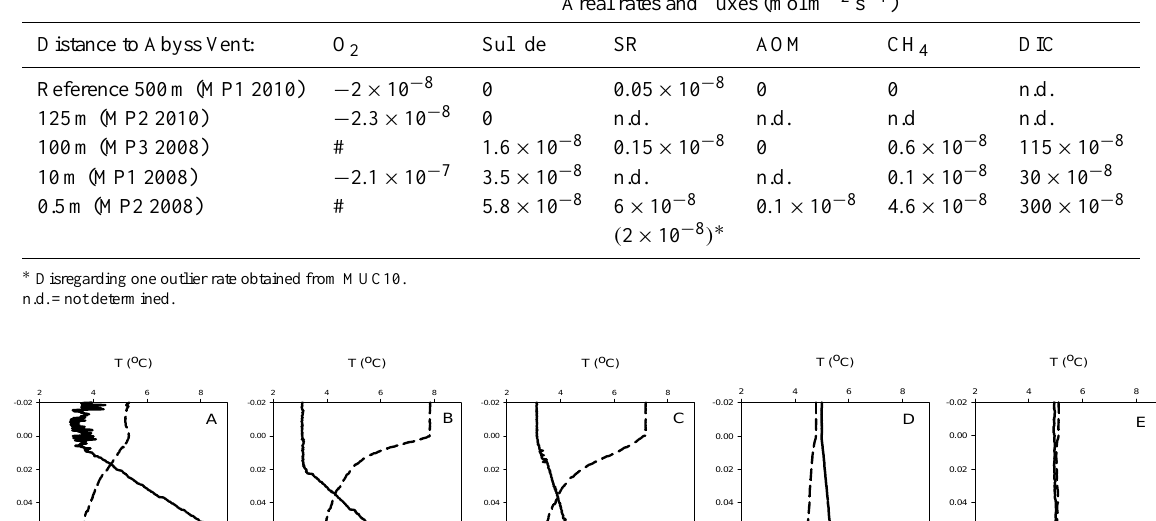
Chimney, which were sampled in 50 cm intervals, starting